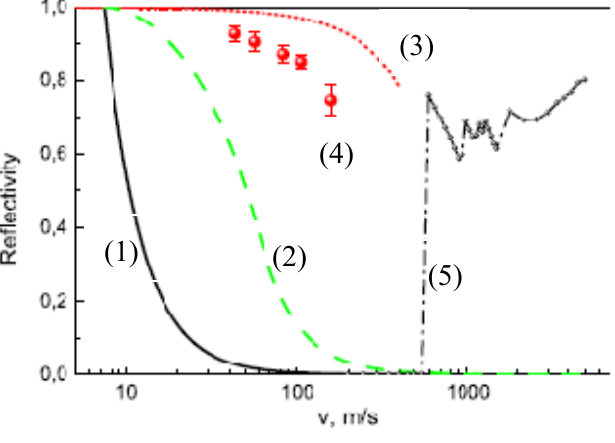
Figure 1. The elastic reflection probability for isotropic neutron flux is shown as a function of the neutron velocity for various carbon-based reflectors: (1) Diamond-like coating (DLC) (thin solid line), (2) The best supermirror [50] (dashed line), (3) Hydrogen-free ultradiamond powder with the infinite thickness (dotted line). Calculation. (4) VCN reflection from 3(cid:1855)(cid:1865) thick diamond nano-powder at ambient temperature (points), with significant hydrogen contamination [49]. Experiment. (5) MCNP calculation for reactor graphite reflector [47] with the infinite thickness at ambient temperature (dashed- dotted